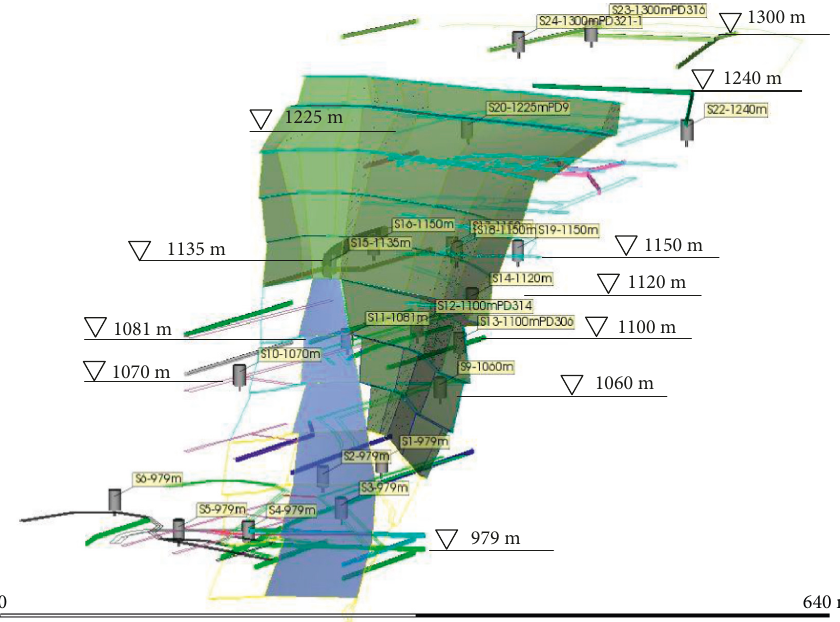
Figure 6: Hyperion digital signal processing system of the MS monitoring system.